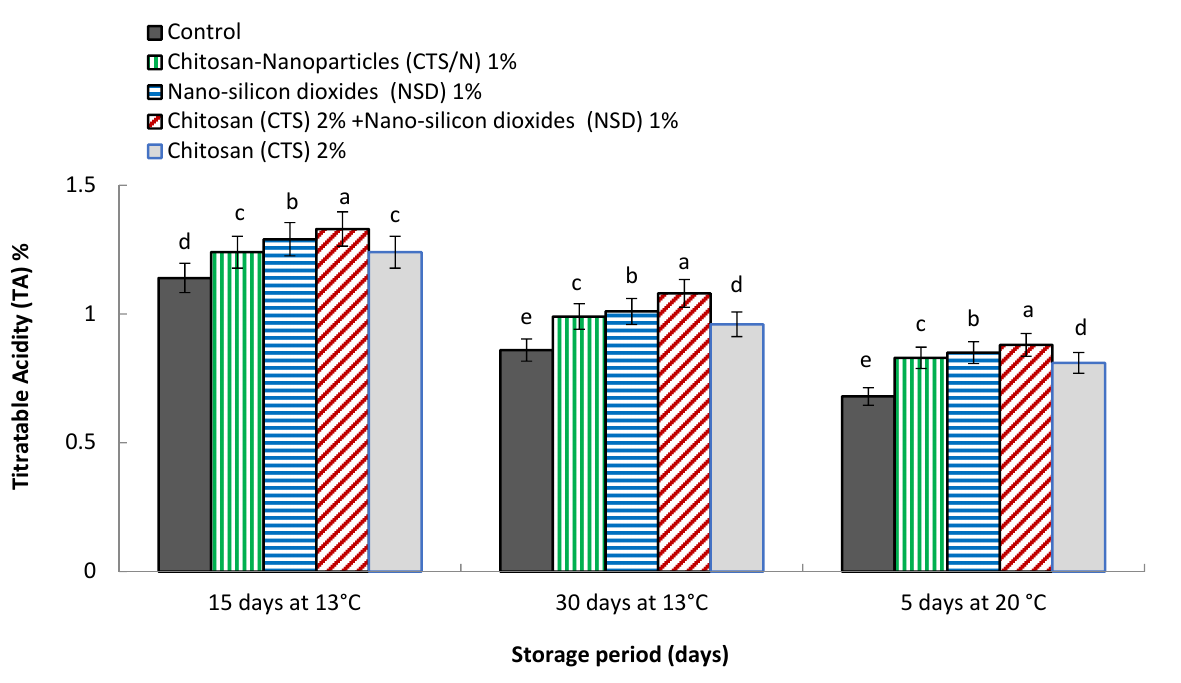
Figure 8. Titratable acidity (TA) % as a mean of ‘Tommy Atkins’ mangoes from two seasons, stored at 13 ± 1 °C and 90–95% RH for 30 days. Afterward, the fruits were stored at 20 ± 2 °C and 70–75% RH for 5 days as the marketing period. Vertical bars indicate the standard error (SE) of the mean ( n = 5). The superscript letters followed by the same letters are not significantly different according to Duncan’s multiple range test at 0.05 level.